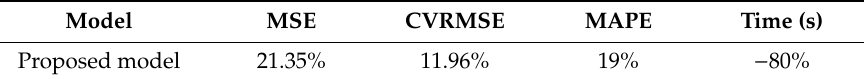
Table 8. Lift percentage of proposed